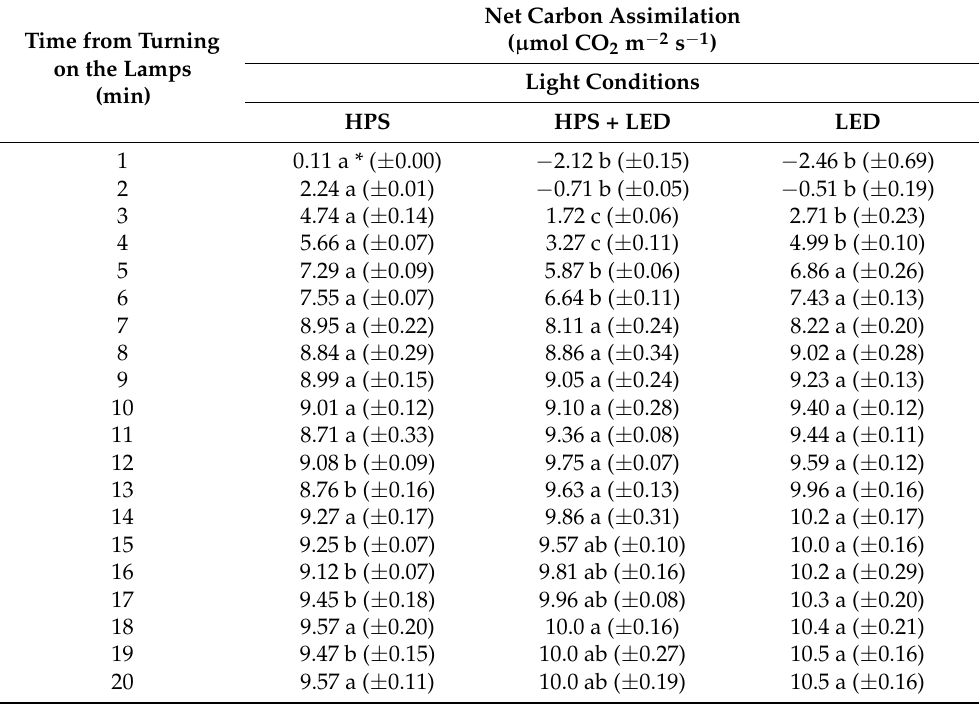
Table 4. Effect of different light sources (HPS, HPS + LED, LED) on the net carbon assimilation measured during the first 20 min after turning on the lamps. Data are given as mean ± SE, n = 3. Net Carbon Assimilation Time from Turning ( µ mol CO 2 m − 2 s − 1 ) on the Lamps Light Conditions (min) HPS HPS + LED LED 1 0.11 a * ( ±